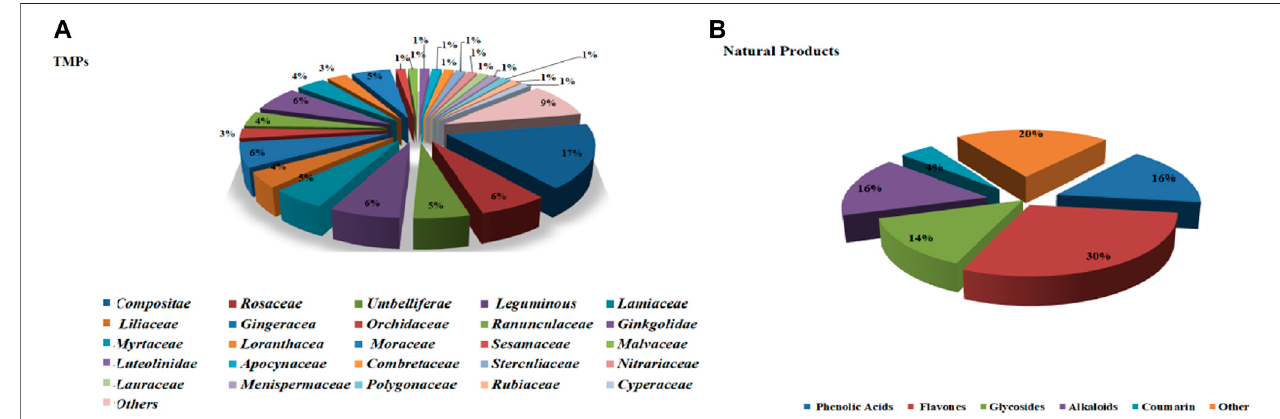
FIGURE 2 | The ratio of TMPs and natural products. (A) : ratio of TMPs in this article (classi fi ed by family); (B) : ratio of natural products in this article (classi fi ed by compound type).